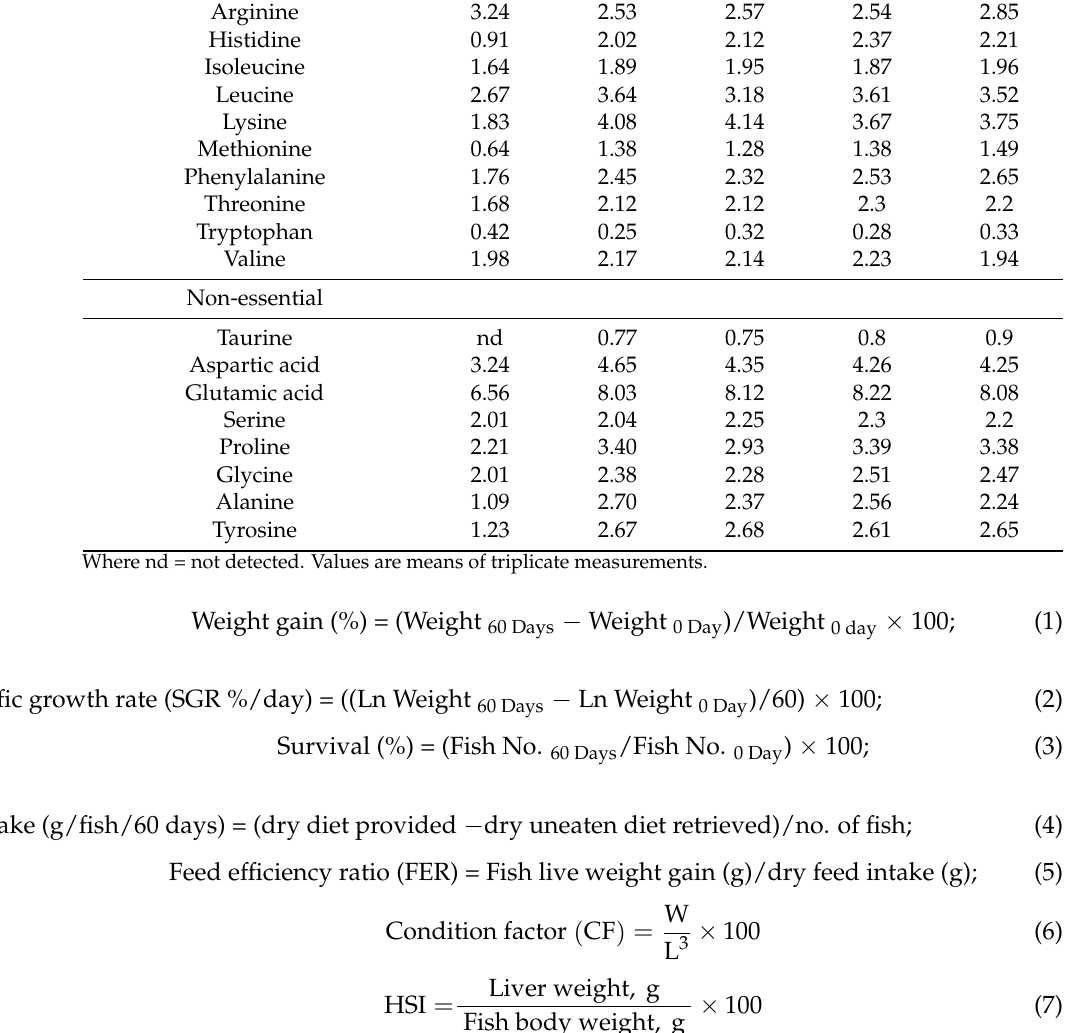
Table 2. Amino acid content (AA g/100 g diet, dry matter basis) (mean ± standard error, n = 3) of the experimental diets fed to red seabream for 60 days formulated by replacing fish meal with camelina meal at 0 g/kg for reference diet (CM0), 205 g/kg with soybean meal (SBM20.5), 205 g/kg with camelina meal (CM20.5) and 330 g/kg camelina meal (CM33). Amino Acids CM CM0 SBM20.5 CM20.5 CM33 Essential Arginine